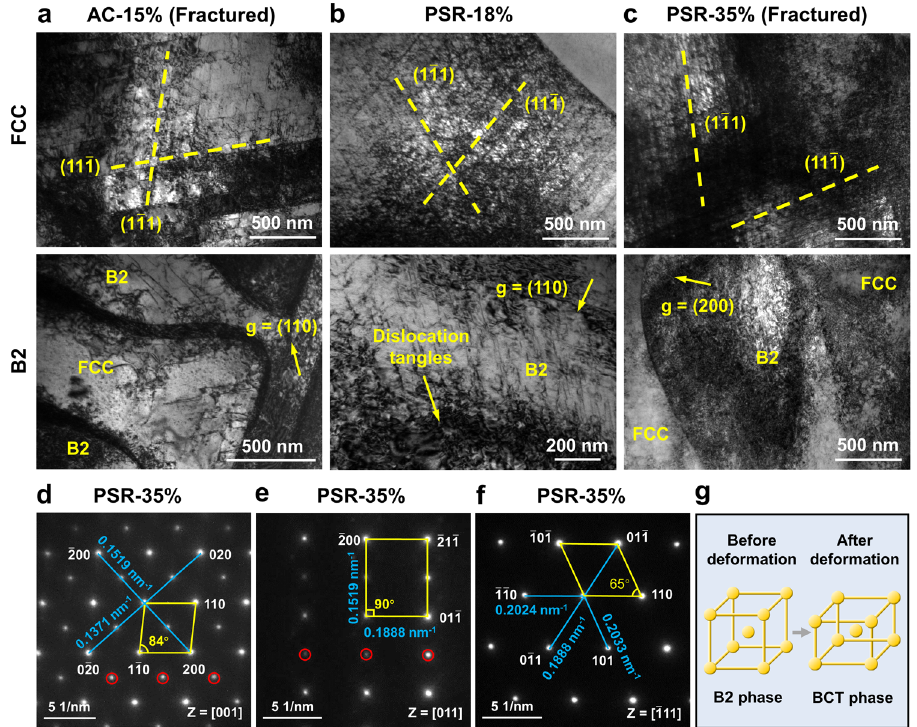
Fig.3|DeformationmechanismsofthePSREHEA.a Dislocationsubstructuresin thefracturedACEHEA. b , c Dislocationsubstructuresinthe18%and 35%stretched PSREHEAs,respectively. d – f SAEDpatternsoftheoriginalB2phaseinthefractured PSRspecimentakenfrom the zone axis of[001],[011], [ (cid:1) 111], respectively,revealing